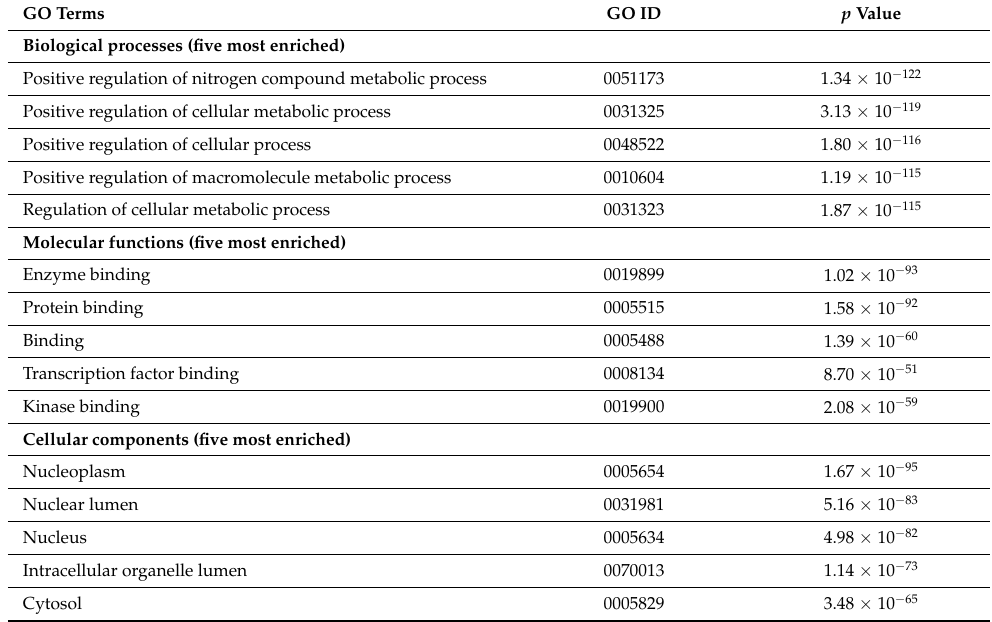
Table 3. GO annotation results for the “external” interaction network. The table shows the five most enriched terms among biological processes, molecular functions, and cellular components for the network of interactions that the 17 human proteins considered in this study establish with the human proteome, as predicted by STRING using minimum required interaction score: highest confidence